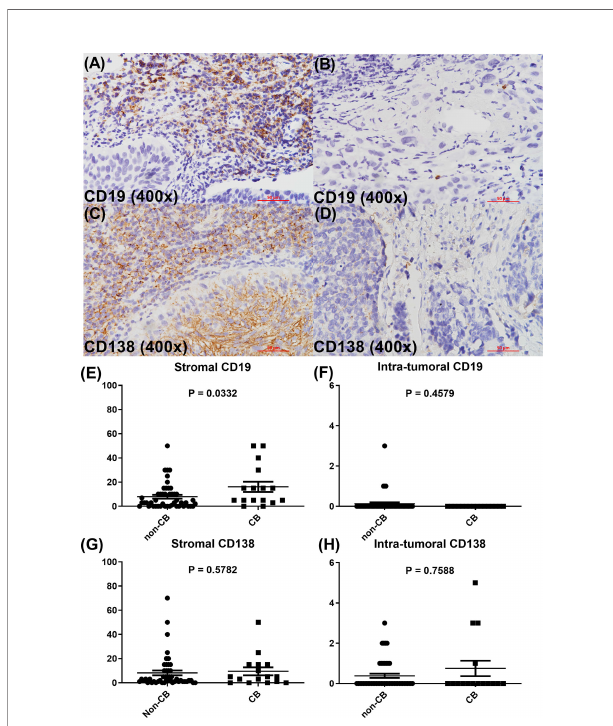
FIGURE 5 | Representative fi gures of stromal and intratumoral CD19 (A, B) and CD138 expression (C, D) . Scatter plots of the immunohistochemistry CD19 (E, F) and CD138 (G, H) expression levels as indicated between CB and non-CB